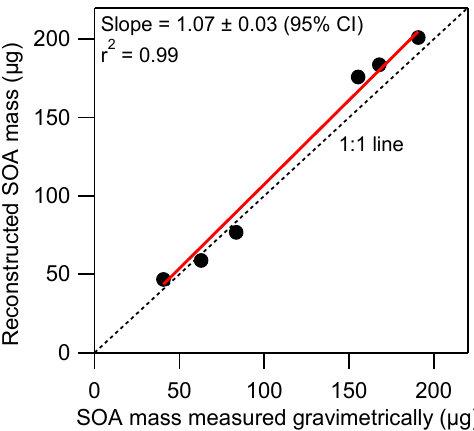
Fig. 2. Comparison of the reconstructed masses of phenolic SOA products ( = TOC × OM/OC) versus their masses measured by gravi- metric analysis. TOC was measured by a total carbon analyzer and OM/OC determined by the HR-AMS. The linear fit with the re- gression through zero was performed using an orthogonal distance regression (ODR) model.